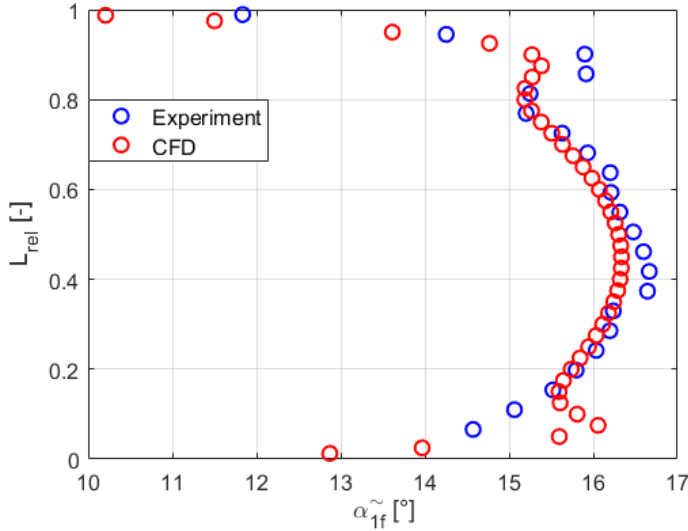
Figure 10. Comparison of the radial distributions of mass-averaged nozzle output absolute velocity (v1).